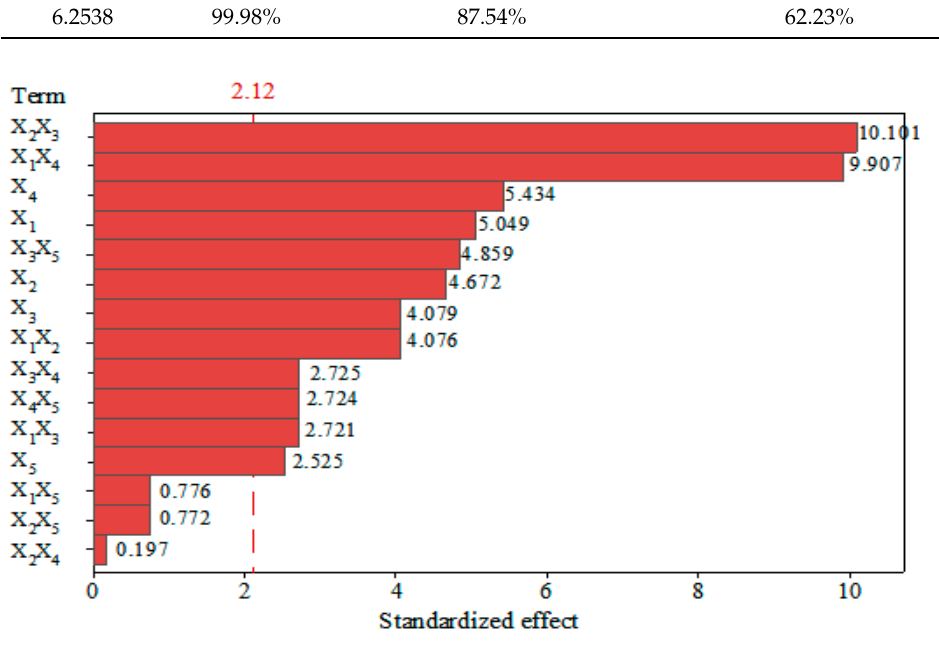
Figure 2. Pareto chart for standardized